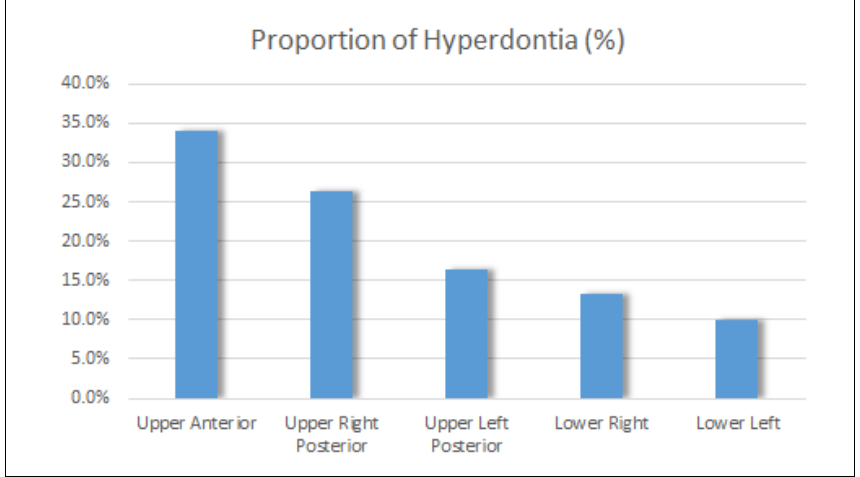
Figure 4. Distribution of hyperdontia in the